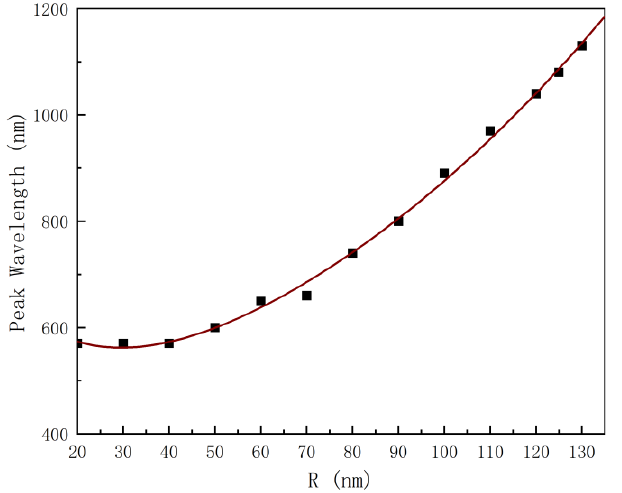
Figure 8. Fitting curve of enhancement peak wavelength and hemisphere radius (R).